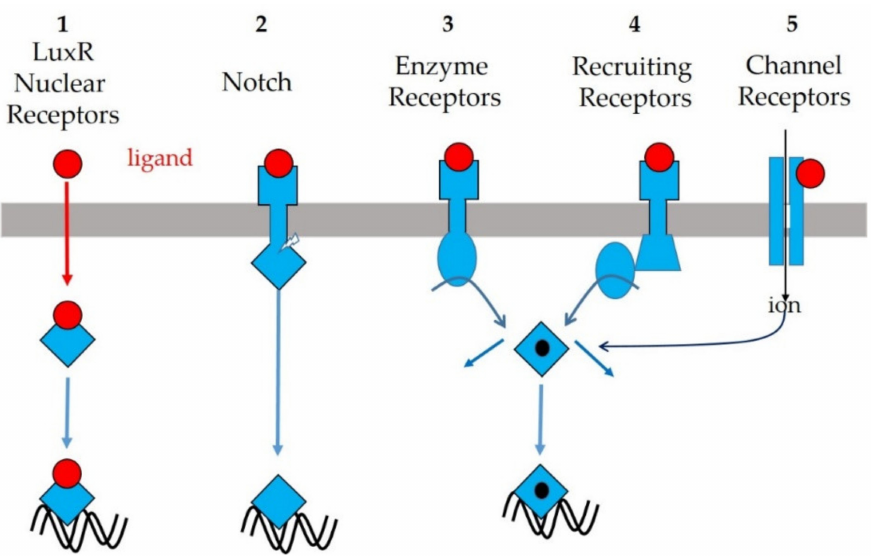
Figure 1. General view of intercellular messengers’ receptors and their downstream signaling pathways. (1) Intracellular ligand-regulated transcription factor. (2)–(5) Plasma membrane receptors: (2) protease-cleavable receptor with intracellular domain exhibiting transcriptional activity; (3) enzyme receptors (Tyr, Ser / Thr, His kinases, GMPcyclase, phosphatase); (4) non-enzymatic receptors recruiting cytoplasmic partners (kinases, G proteins, sca ff olding proteins); and (5) channel receptors (ionotropic). For details, see also Table